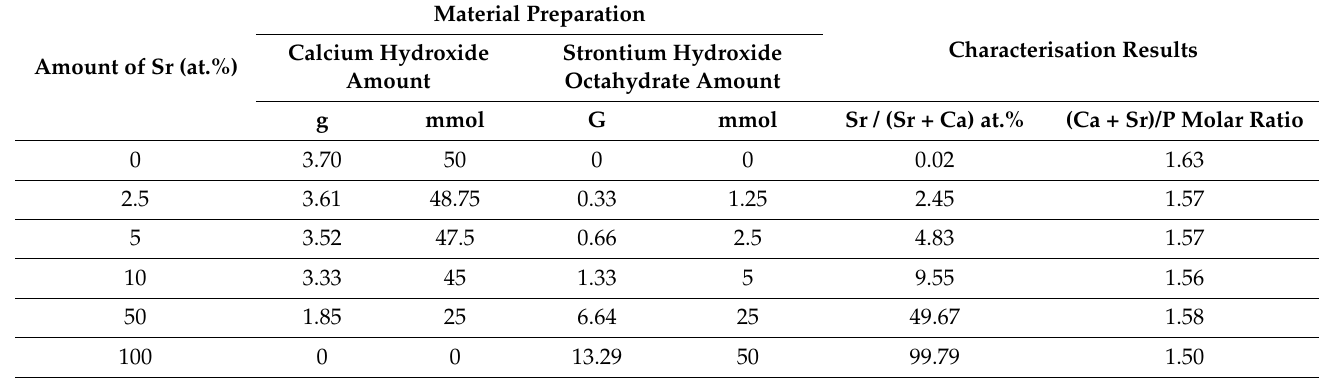
Characterisation ResultsCalcium